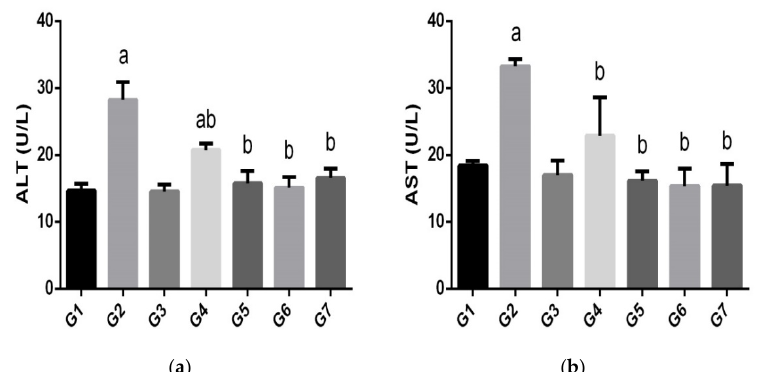
Figure 5. Histograms showing the effects of the nanoparticles on serum transaminases in the control and experimental groups infected with E. stiedae . Values are the means ± SEMs (n = 7). ( a ) Significant difference at p < 0.05 concerning the negative control group (a,b). ( b ) Significant difference at p < 0.05 concerning the positive control group.